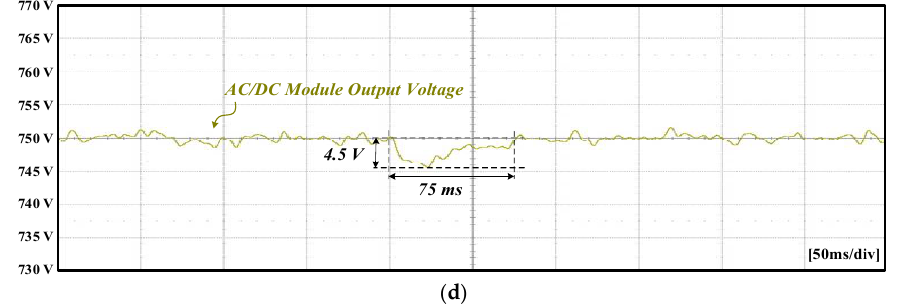
Figure 14. Experimental waveforms with the proposed method. ( a ) Reference and real voltage; ( b ) reference and real voltage of DC Bus (expanded); ( c ) reference and real q -axis current in synchronous frame; and ( d ) output voltage of module 1 (expanded).